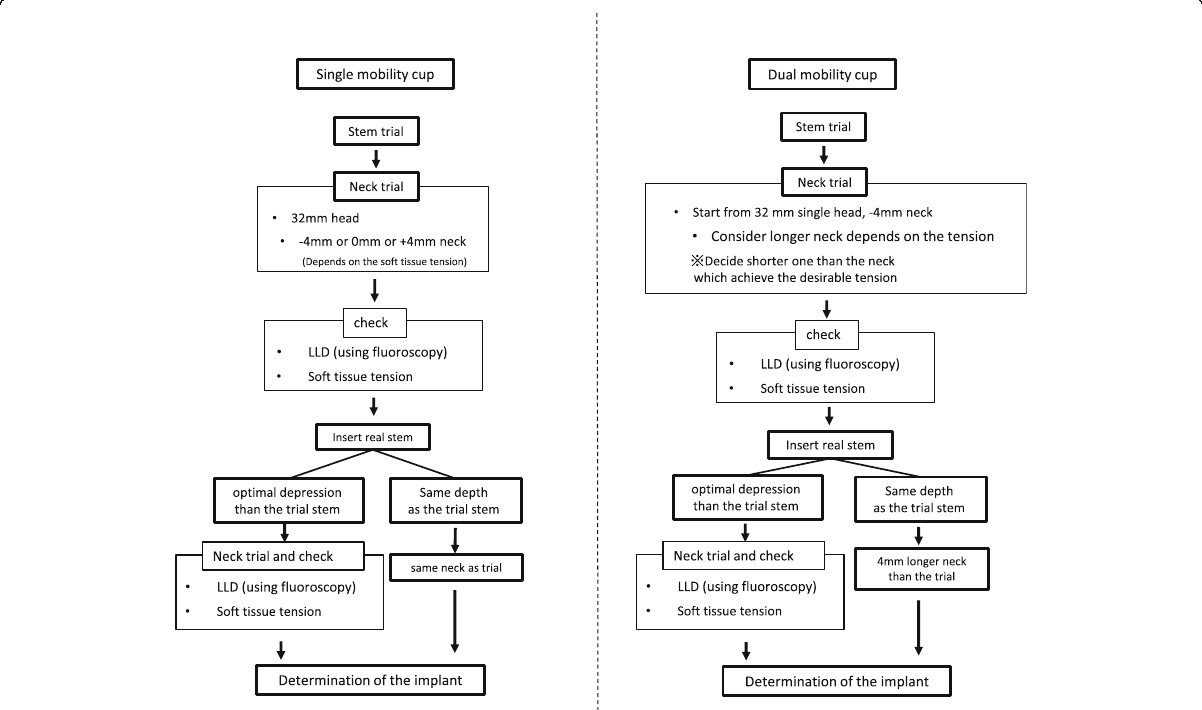
Fig. 1 Operative protocol of reduction/dislocation phase using trial and leg length